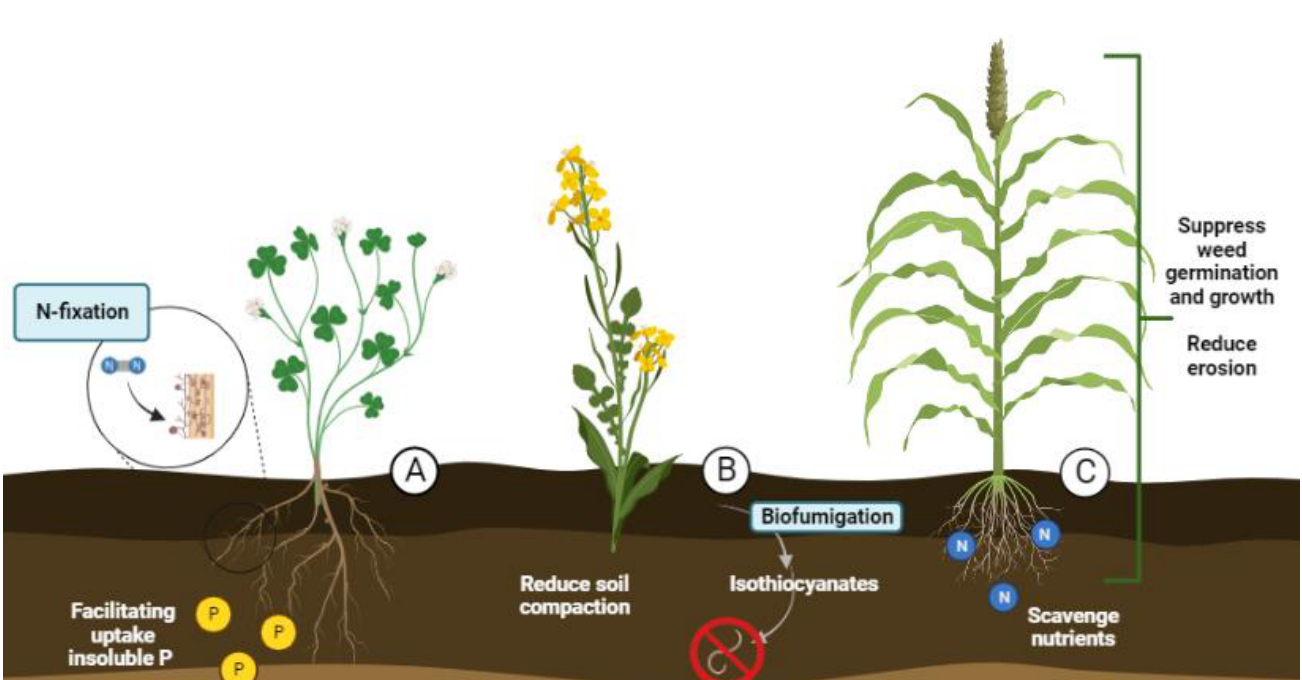
Figure 2. Schematic diagram explaining the role of different type of cover crops in the agroecosys- tems and their main ecological services. A = Gramineous species, B = Brassicaceous species, C = Leguminous species.